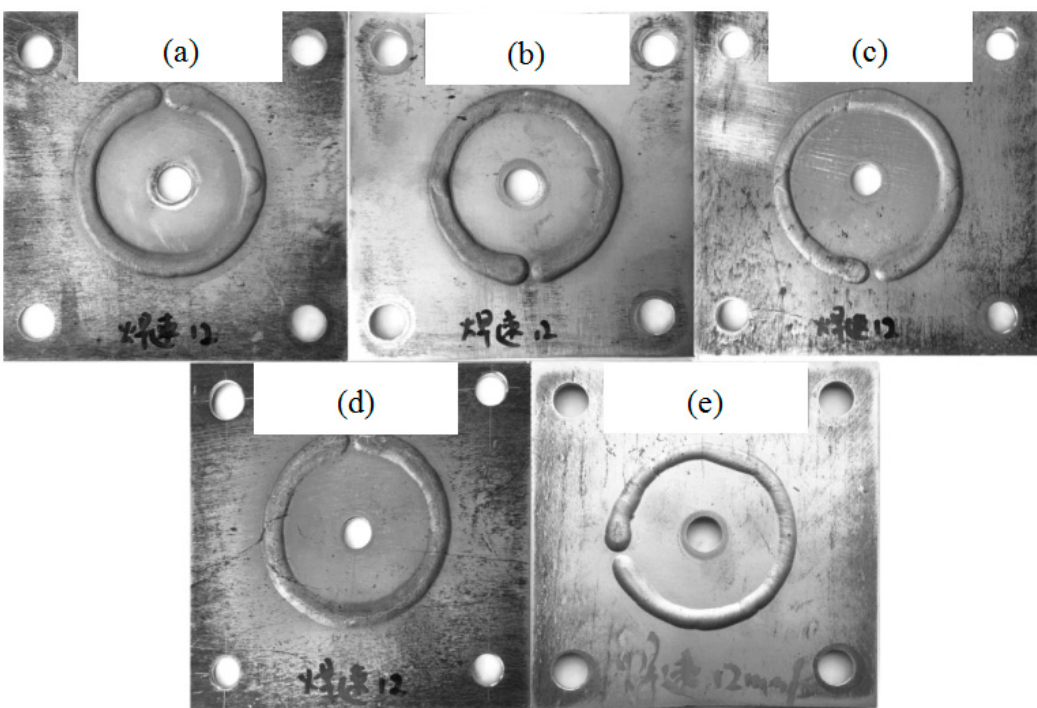
Figure 4. Representative images of post-weld workpieces: ( a ) Alloy 1, ( b ) Alloy 2, ( c ) Alloy 3, ( d ) Alloy 4, and ( e ) Alloy 5.